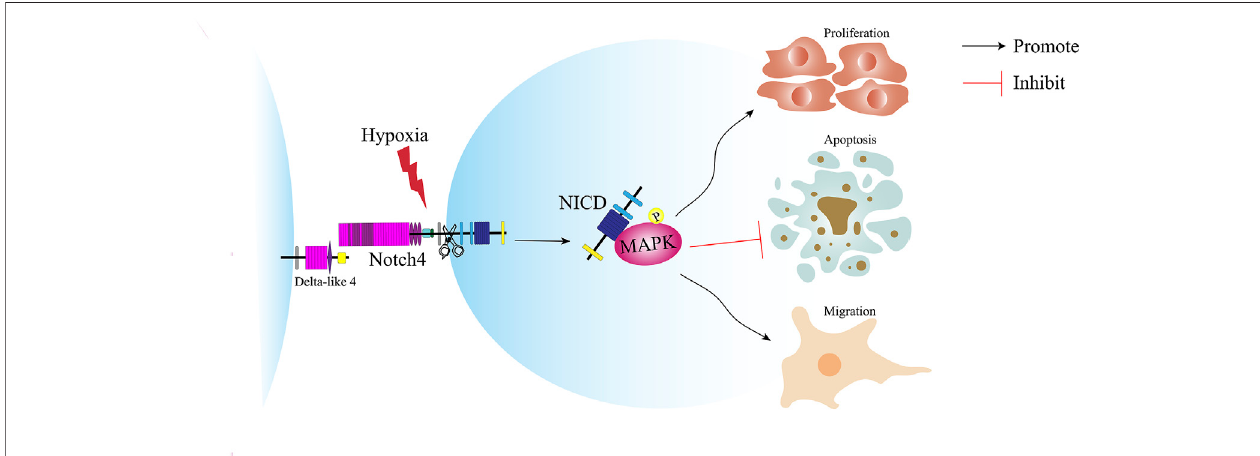
FIGURE 8 | Schematic illustration of the role of Notch4 in the proliferation, apoptosis and migration of LUAD cells. Hypoxia induces the expression of Notch4. Increased level of Notch4 promotes cell proliferation, migration, and apoptosis resistance in A549 and H1299 cells. Hypoxia activates Notch4 via ERK/JNK/P38 MAPK signaling pathways topromote lung adenocarcinoma progression and metastasis.LUAD,lung adenocarcinoma; ERK, extracellularsignal-regulated kinase; JNK, c-Jun N-terminal kinase; MAPK, mitogen-activated protein kinase.